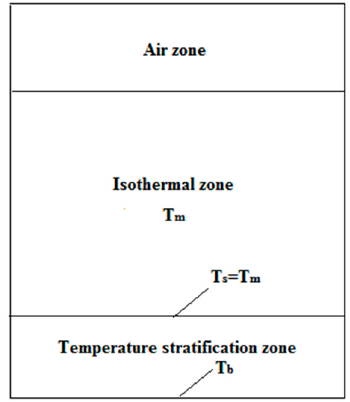
Figure 4. Model of the temperature stratification in the tank.